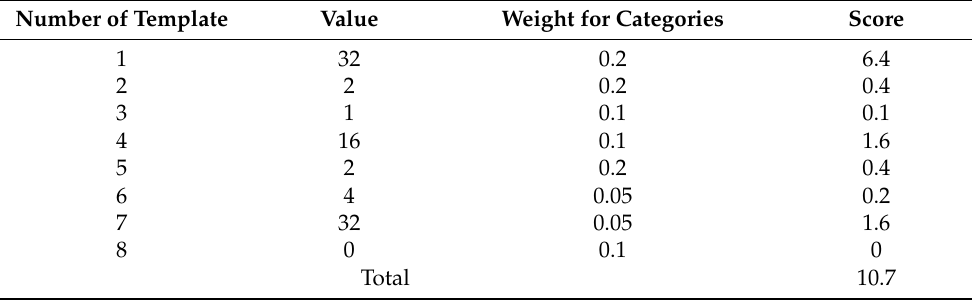
Table 11. Aggregation of the consequences for flood risk assessment.